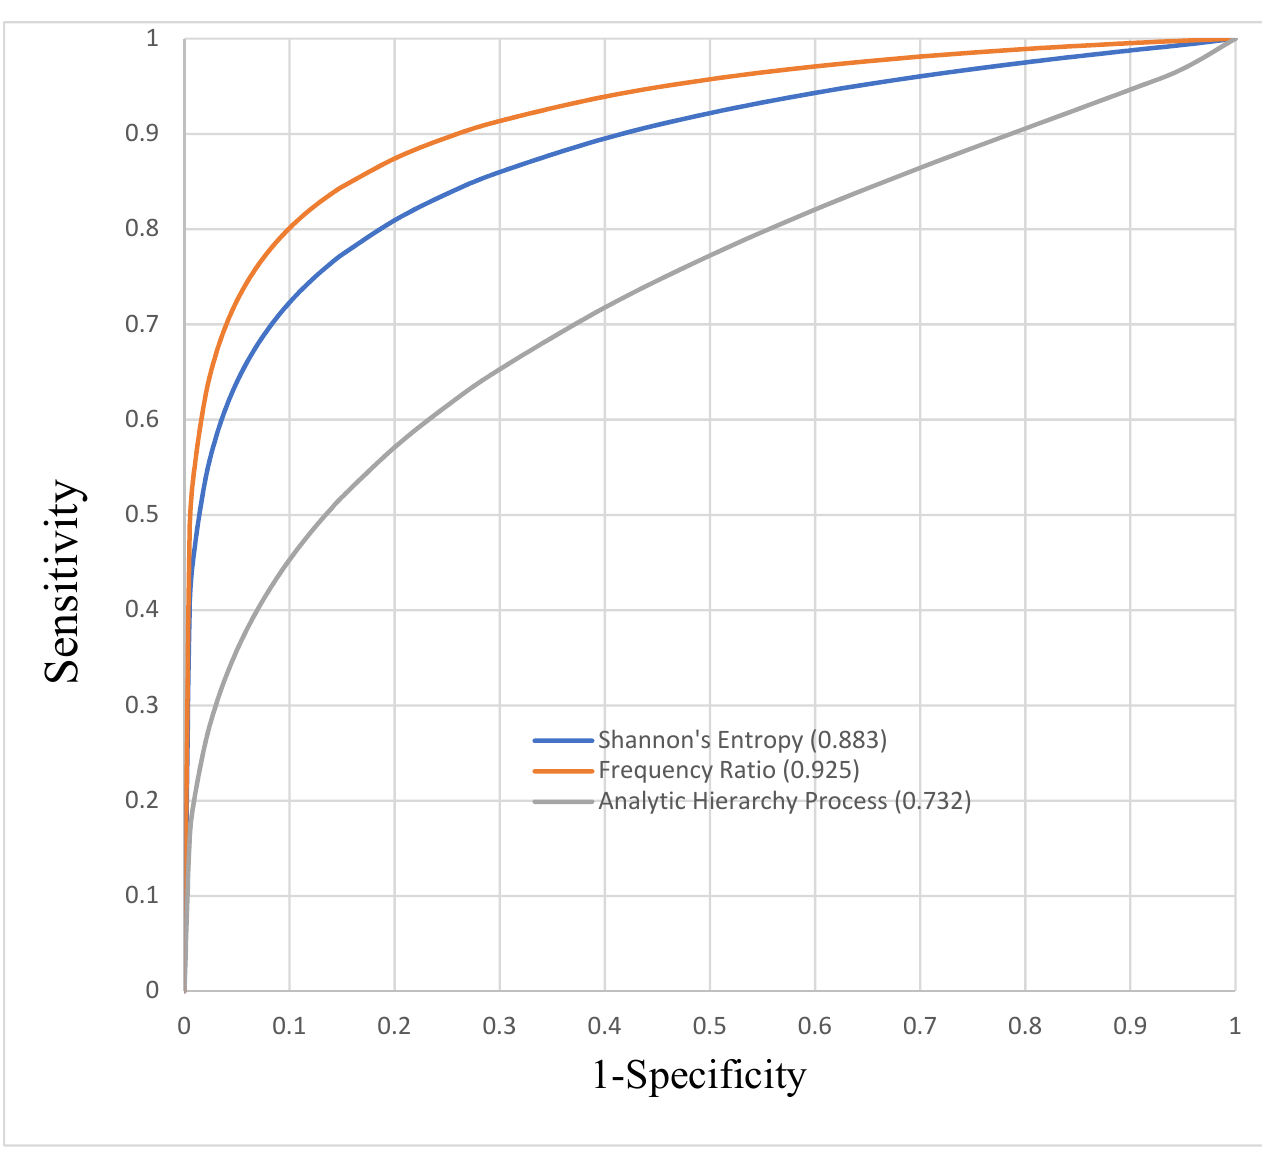
Figure 8. Receiver operating characteristic curve for validation.